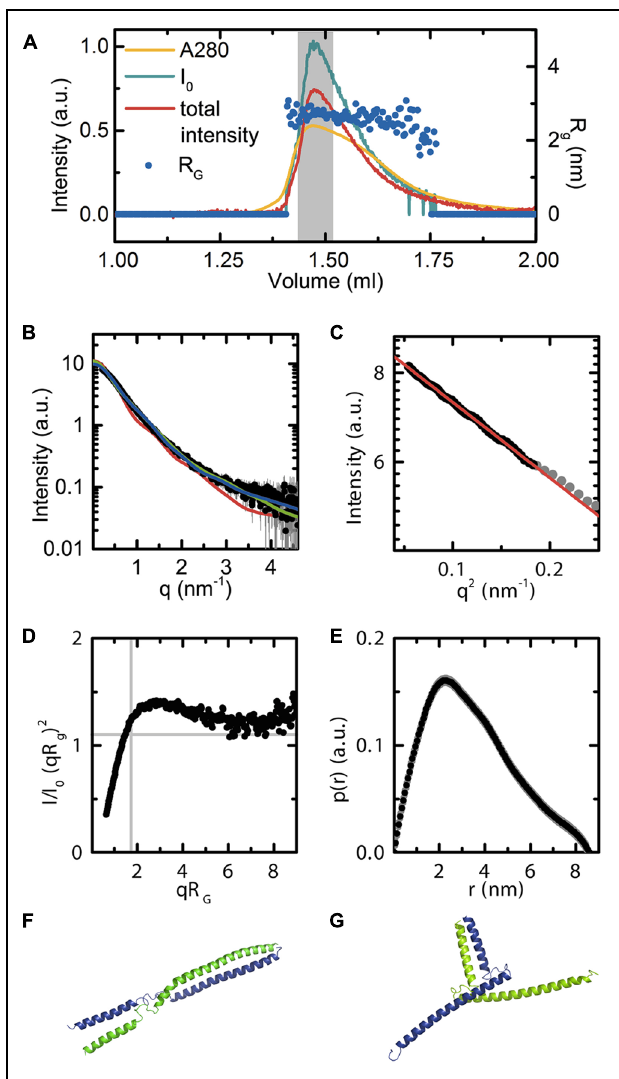
FIGURE 7 | Small angle X-ray scattering data for AG ( 74 − 173 ) . (A) Experimental data showing the UV absorbance (yellow), X-ray scattering intensity (blue), and total intensity after buffer subtraction (red) for all collected frames. The radius of gyration across frames corresponding to the eluted peak are shown as dark blue dots (R g = 2.7). The broad peak and slight variation in R g corresponds to conformational flexibility of the protein in solution. The region of frames integrated for further analysis are highlighted in gray. Axes are as labeled. (B) Scattering curve in black for the integrated frames. CRYSOL fits for the bent and elongated dimer conformations, as well as the tetrameric SEP3 structure. Chi squared values were 5.6 for the elongated model (blue curve), 2.0 for the bent model (green curve) and 38.4 for the tetrameric model (red curve). (C) Close-up of the Guinier region. The linear fit demonstrates no evidence of aggregation of the protein. (D) Normalized Kratky plot calculated using the integrated frames. The shape of the curve is indicative of a flexible particle. (E) P(r) function. The calculated Porod volume for the particle is 36 nm 3 . Based on the Porod volume, the molecular mass of the particle is approximately 21 kDa. (F) Elongated homology model for AG ( 74 − 173 ) . The homology model was based on the SEP3 K domain (4OX0) and secondary structure predictions for AG. Each monomer is depicted as a cartoon and colored blue and green. (G) Bent homology model for AG ( 74 − 173 ) . Each monomer is depicted as a cartoon and colored blue and green. The homology models (F,G) were used for fitting the data using CRYSOL as shown in (B)